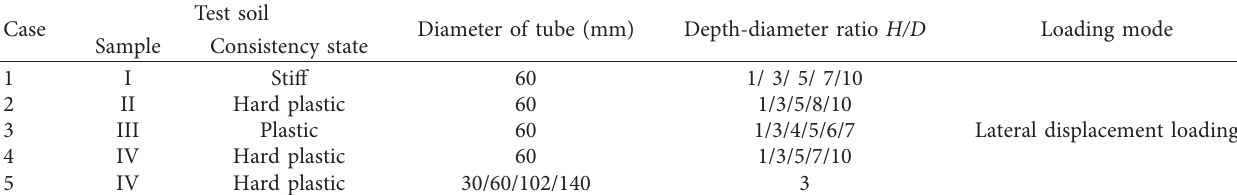
Table 2: Test cases.